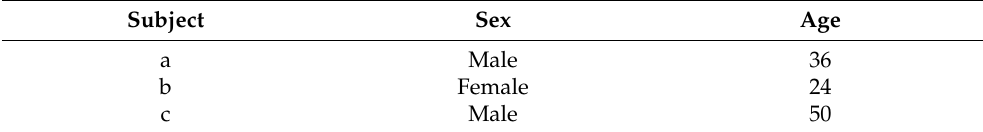
Table 1. Demographic data of